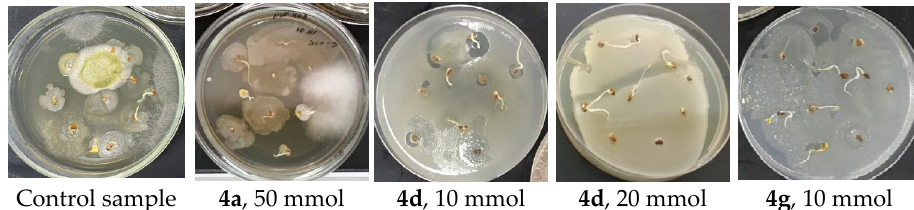
Figure 6. Growth of microflora on alfalfa seeds treated with compounds.